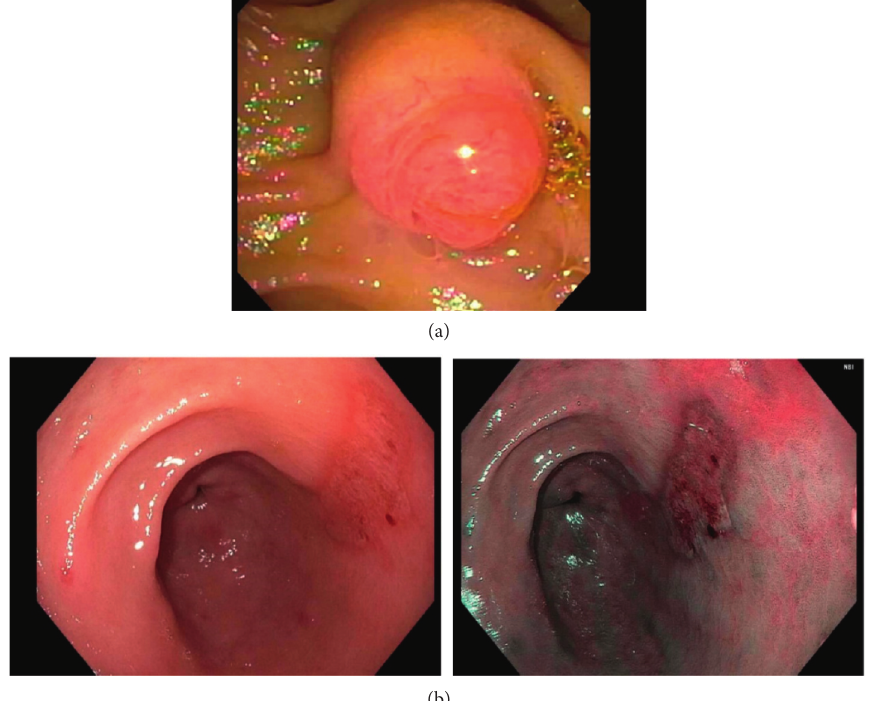
Figure 1: (a) Prominent and bulging major ampulla and (b) antral gastritis (superficial gastric